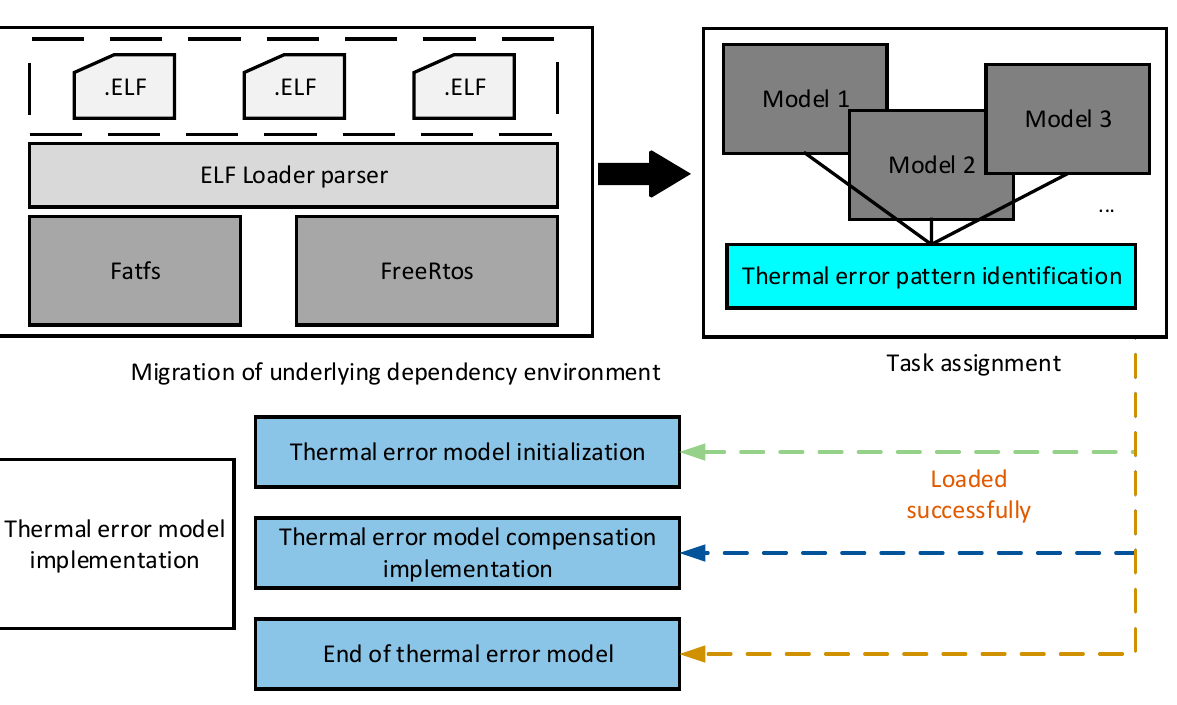
Figure 17. ELF load module migration workflow diagram.